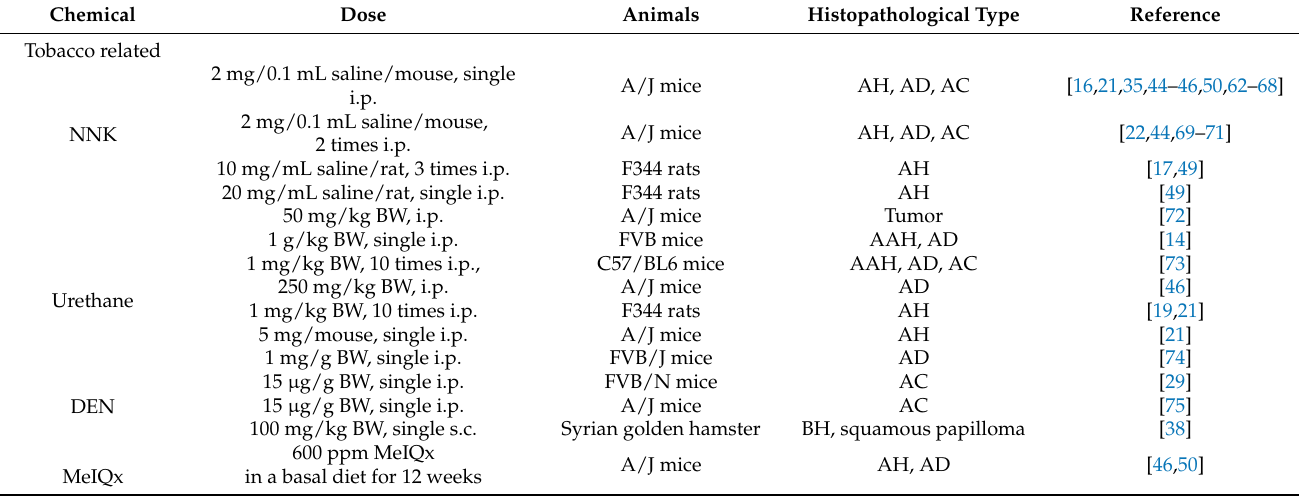
Table 1. Chemical induced lung tumorigenesis in animal